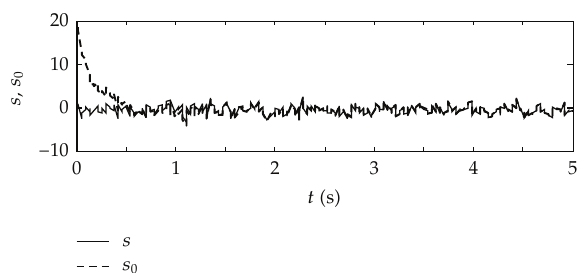
Figure 7: The original message and the recovered